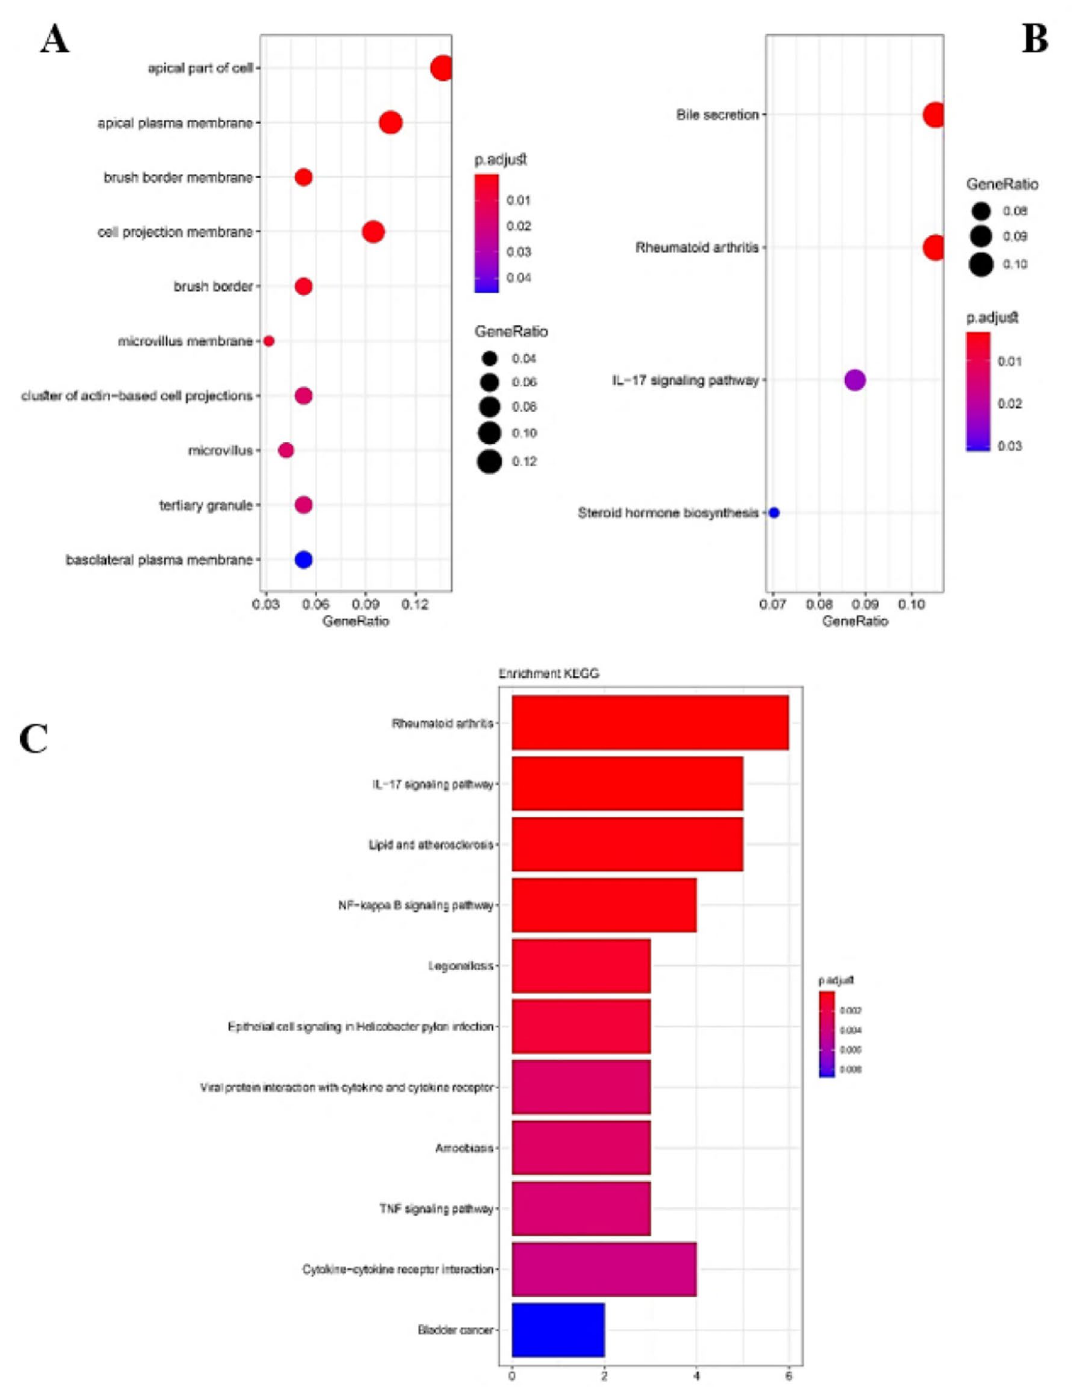
Figure 10. Bubble plot and bar chart analysis (KEGG) analysis of overlap DEG enrichment pathway by ClusterProfiler and Rplot packages. ( A ) Cellular component (CC) ( C and B ) pathways of